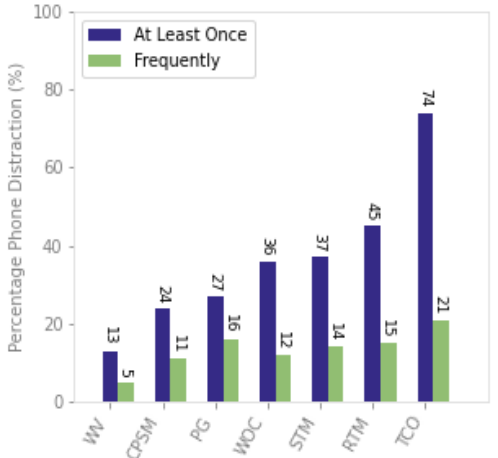
Figure 1. Statistics showing the percentage distribution of drivers committing various types of distraction including watching videos on smartphone/tablet (WV), checking or posting to social media (CPSM), personal grooming (PG), watching something on a cell (WOC), sending text messages (STM), reading text messages (RTM), and talking on a cell phone (TCO) (https://www.statista.com/ chart/3010/driving-distractions/, accessed on 19 June 2022).